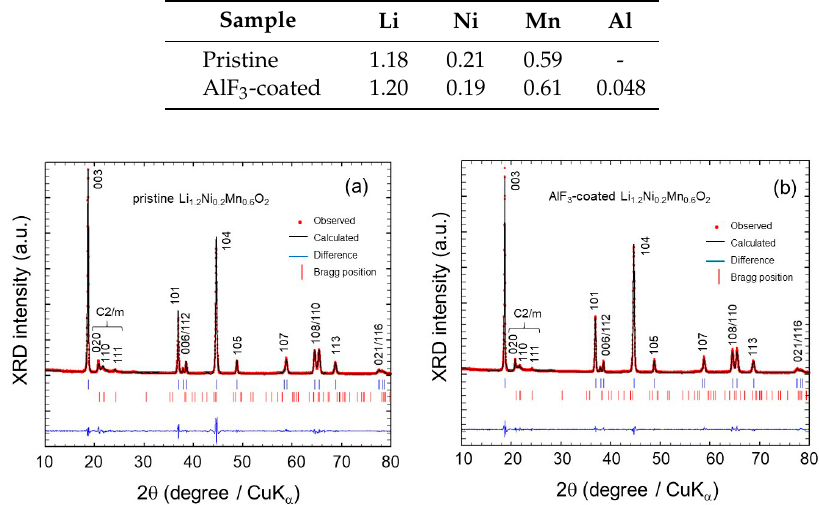
Table 1. Elemental composition of LLNMO samples analyzed by ICP-AES.